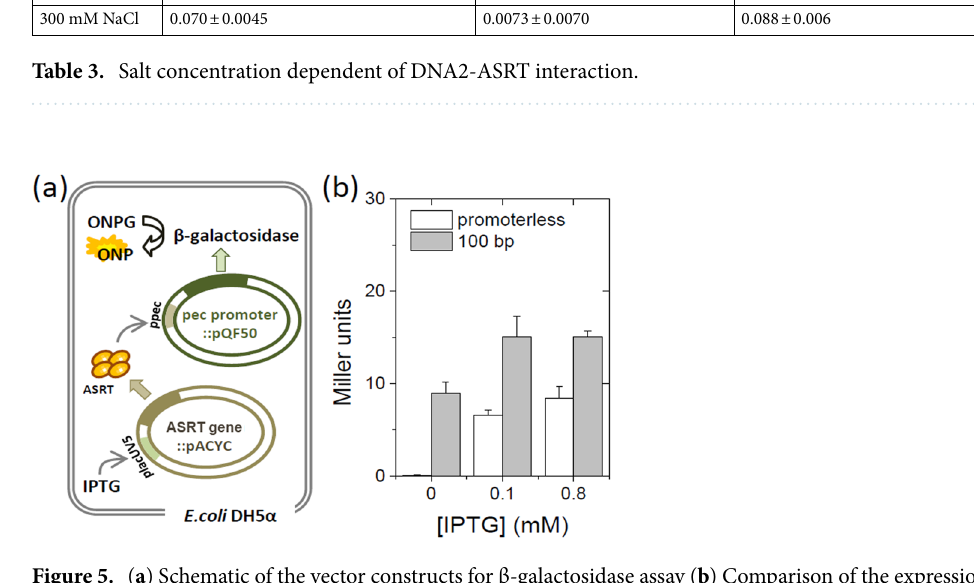
Figure 5. ( a ) Schematic of the vector constructs for β-galactosidase assay ( b ) Comparison of the expression level of β-galactosidase in Miller units in the absence of promoter (QF50, white bars) and 100 bp pec promoter (gray bars) inserted into the vector at two different induction conditions. Error bar are standard errors from three independent